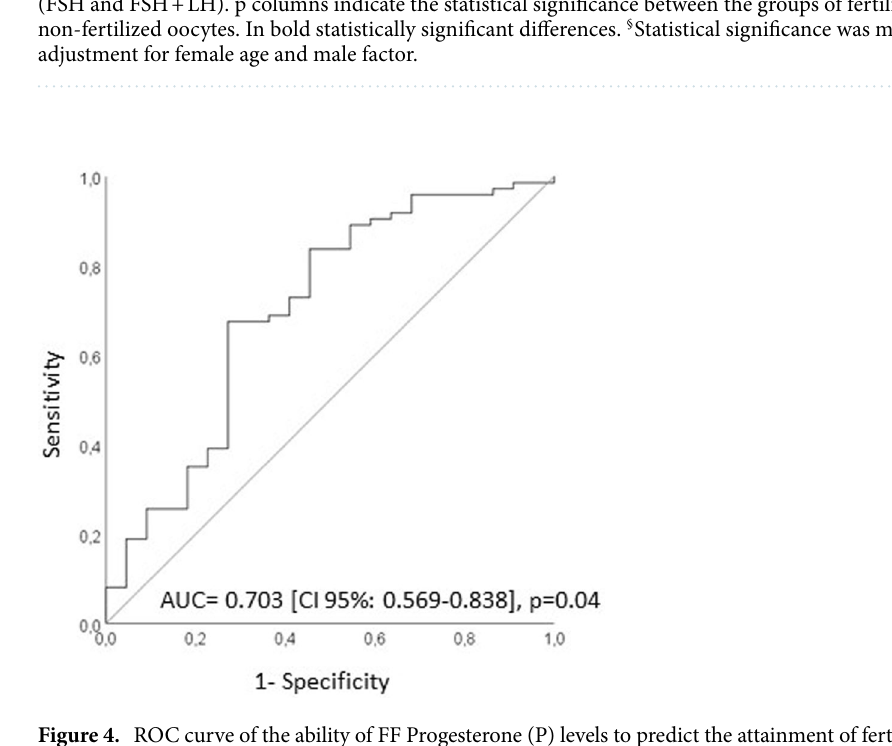
Figure 4. ROC curve of the ability of FF Progesterone (P) levels to predict the attainment of fertilization in FSH group. AUC area under the curve, CI confidence